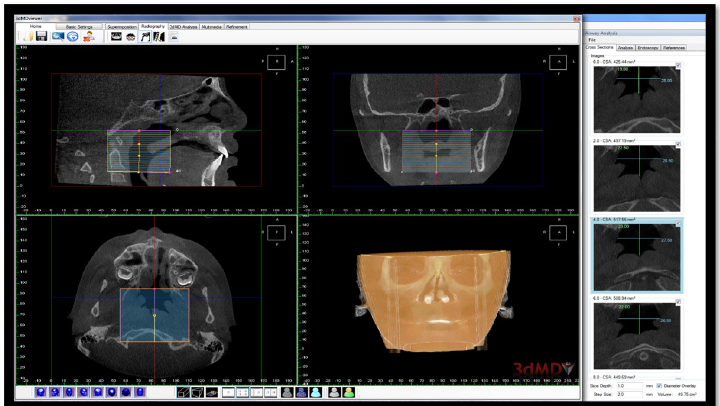
Fig 1. A screen shot from 3dMDvultus software for oropharyngeal airway analysis. Top left pane showing the oropharyngeal airway extending from the palatal plane to the superior tip of the epiglottis that was outlined visually. Cross-sectional areas were calculated for each 2-mm distance over the entire length of the airway. The right pane shows each slice with the cross-sectional areas calculated.